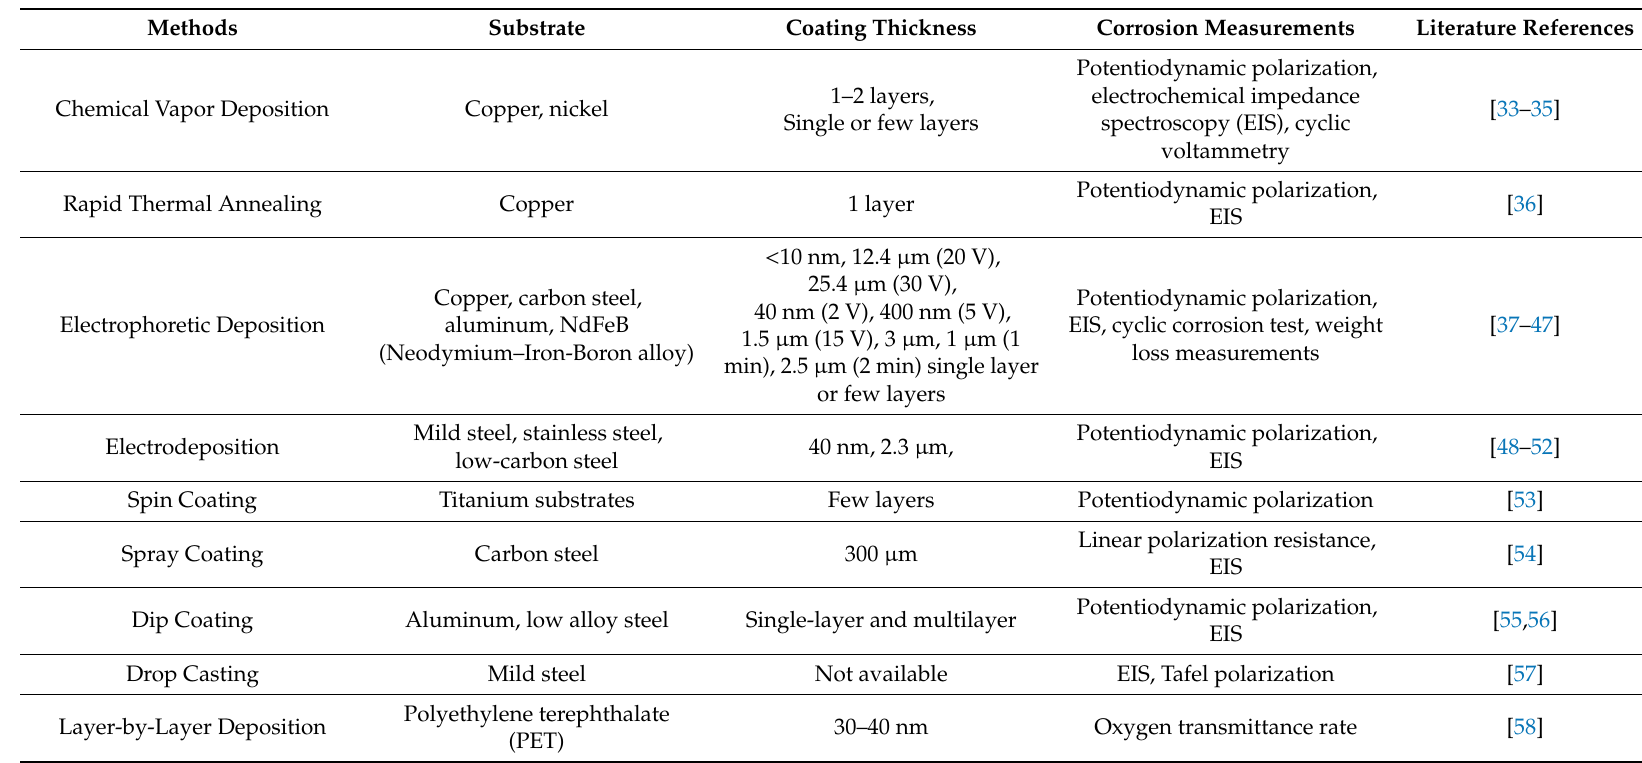
Table 2. Overview of protective graphene coatings deposited by di ff erent